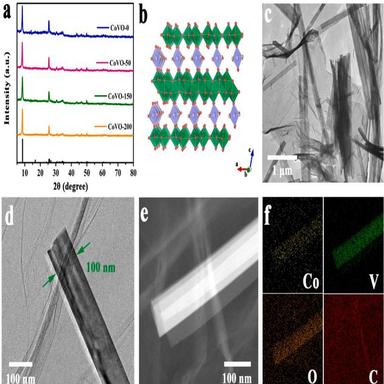
(a) XRD patterns of CoVO-0, CoVO-50, CoVO-150, CoVO-200 and standard phase, (b) the structure of Co0.25V2O5•nH2O, (c) TEM image of CoVO-150, (d) TEM image of a single nanoribbon, (e) HAADF-STEM image of CoVO-150, (f) elemental mapping results of CoVO-150.